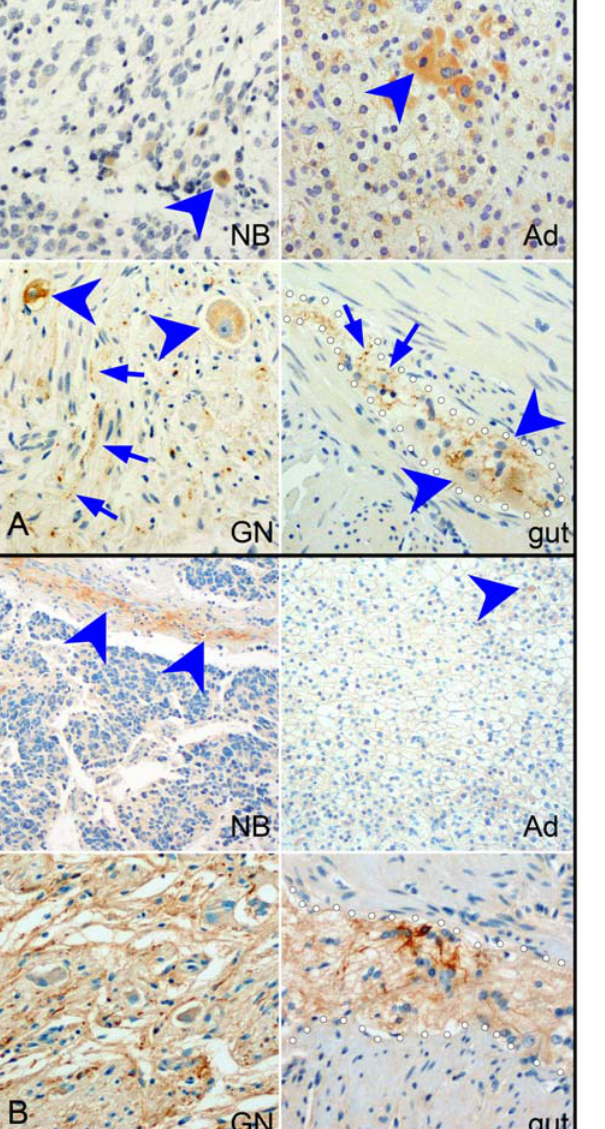
by HH pathway activity, including anti-mullerian hormone ( AMH ) [28] and plakoglobin [29] were specifically down-regulated in the GNs (Table 2). The differential expression of HH targets in GN demonstrates the active influence of the HH pathway.